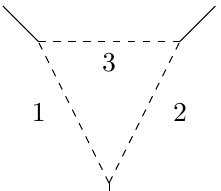
Figure 11 . Three-scale triangle: s 1 = (cid:0) p 2